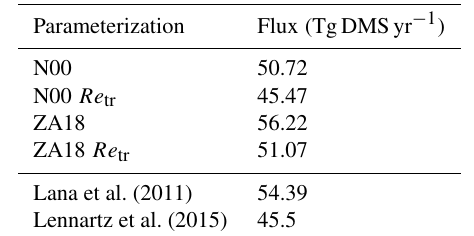
Table 3. 2014 DMS flux in teragrams. Re tr indicates an applica- tion of the gas transfer suppression model. The last two rows are estimated from global